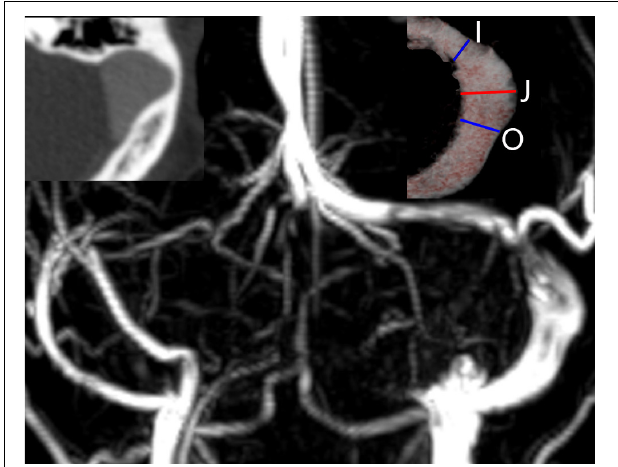
FIGURE 1 | Imaging features of a prominent transverse-sigmoid sinus junction (PTSJ). The PTSJ is located between the blue lines indicating inlet flow (I) and outlet flow (O). The red line (J) indicates the largest PTSJ area.